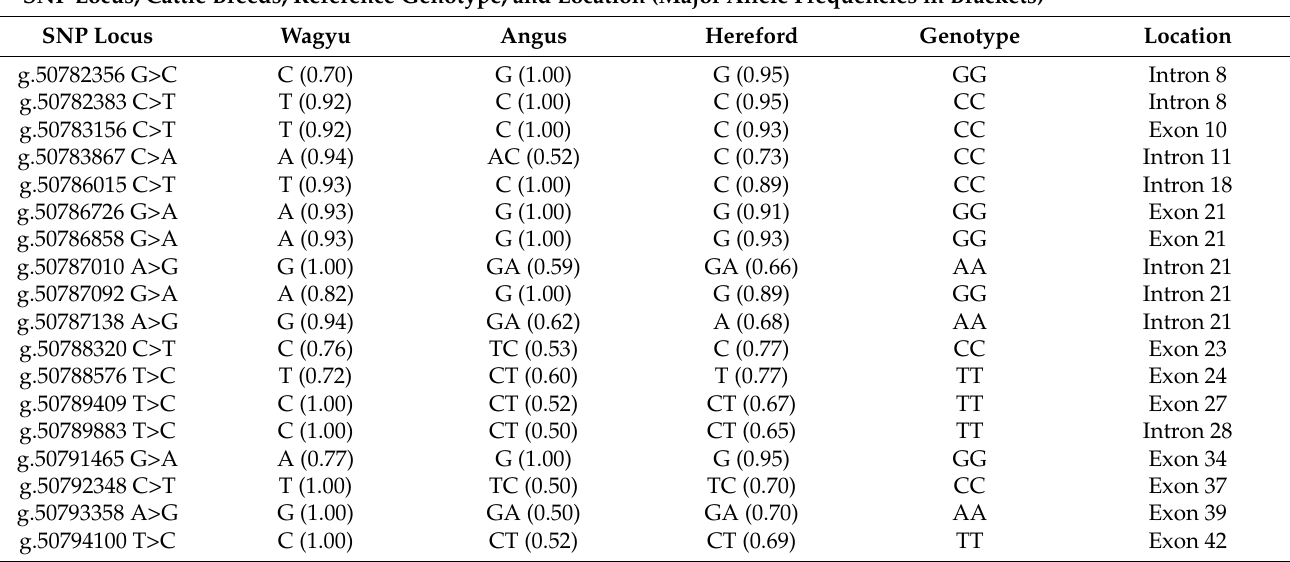
Table 3. FASN gene SNP in Bowen Genetics Forest Pastoral Angus, Hereford, and Wagyu beef cattle. SNP Locus, Cattle Breeds, Reference Genotype, and Location (Major Allele Frequencies in